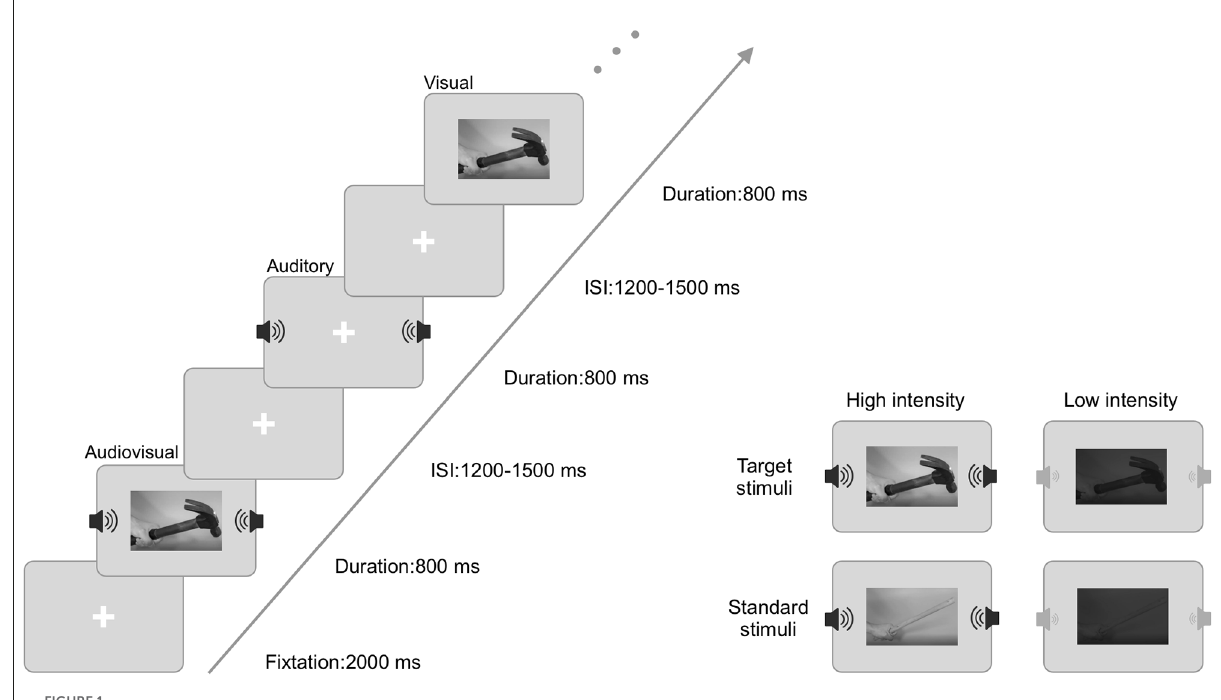
FIGURE1 Schematic diagram of the experimental